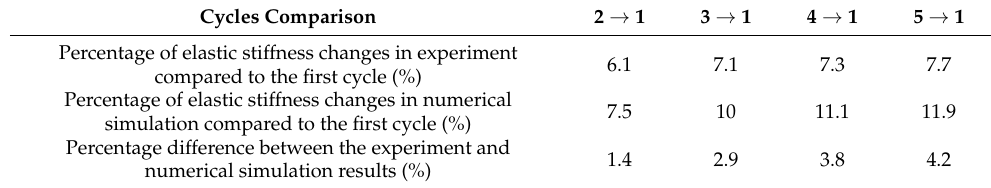
Table 3. Summary of the ES percentage changes in the experiments and numerical simulation, induced by cyclic compressive